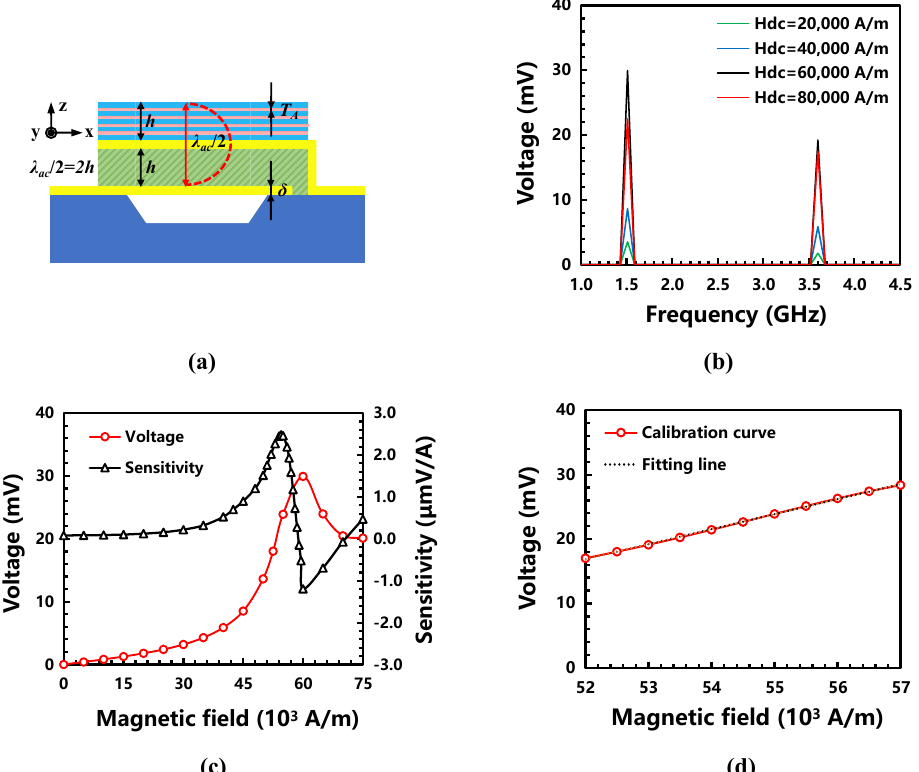
Figure 7. The performance of the BAW ME magnetic sensor: ( a ) the finalized design of the BAW ME magnetic sensor; ( b ) the output voltage variation at the first-order and the second-order resonance frequencies; ( c ) the output voltage and sensitivity at the first-order resonance frequency under different DC bias magnetic fields; ( d ) the linearity and the measurement range with a DC bias of 54,500 A/m.